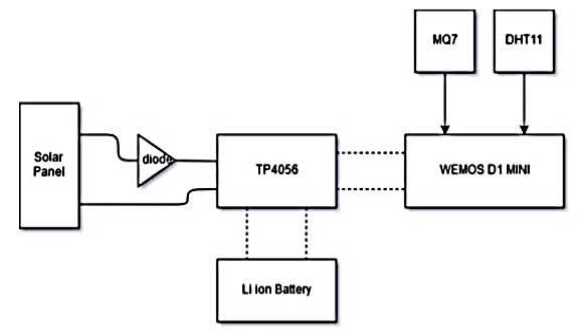
Figure.1. Block diagram of the system